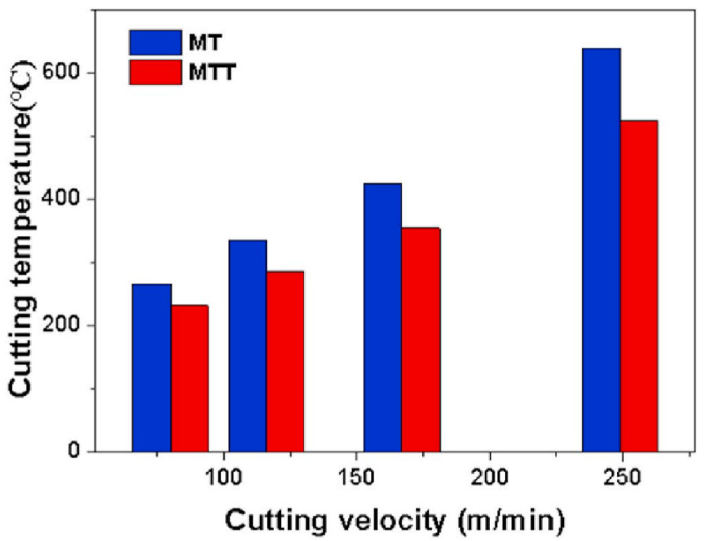
Figure 27. Cutting temperatures of the MT and MTT [76].